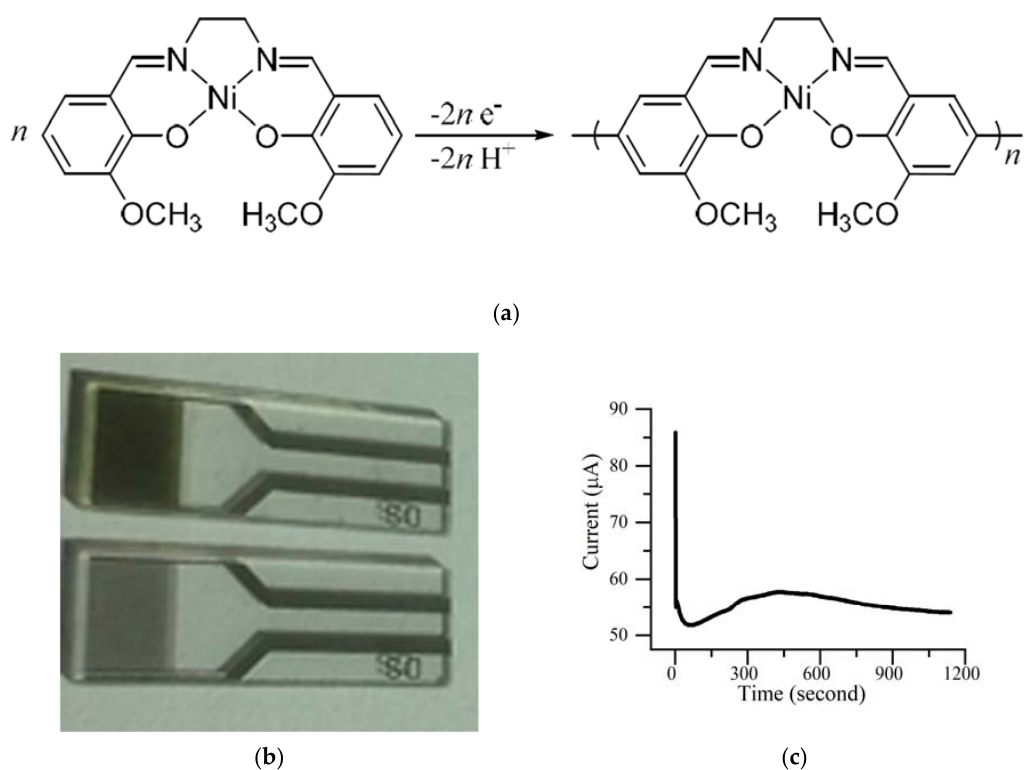
Figure 1. The scheme of the electropolymerization reaction: ( a ) polymer coated (left) and pristine (right) IDE electrodes and ( b ) polymer electrodeposition current versus time at a potential of 850 mV in a 5 mM monomer solution in acetonitrile with 0.1 M LiBF 4 ( c ).